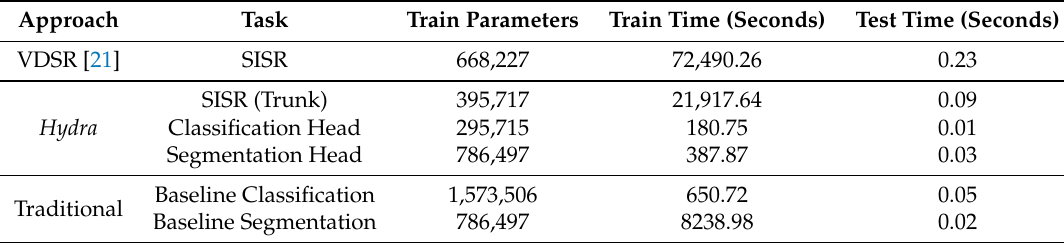
Table 6. Summary of training parameters and time for Hydra , VDSR, and the traditional